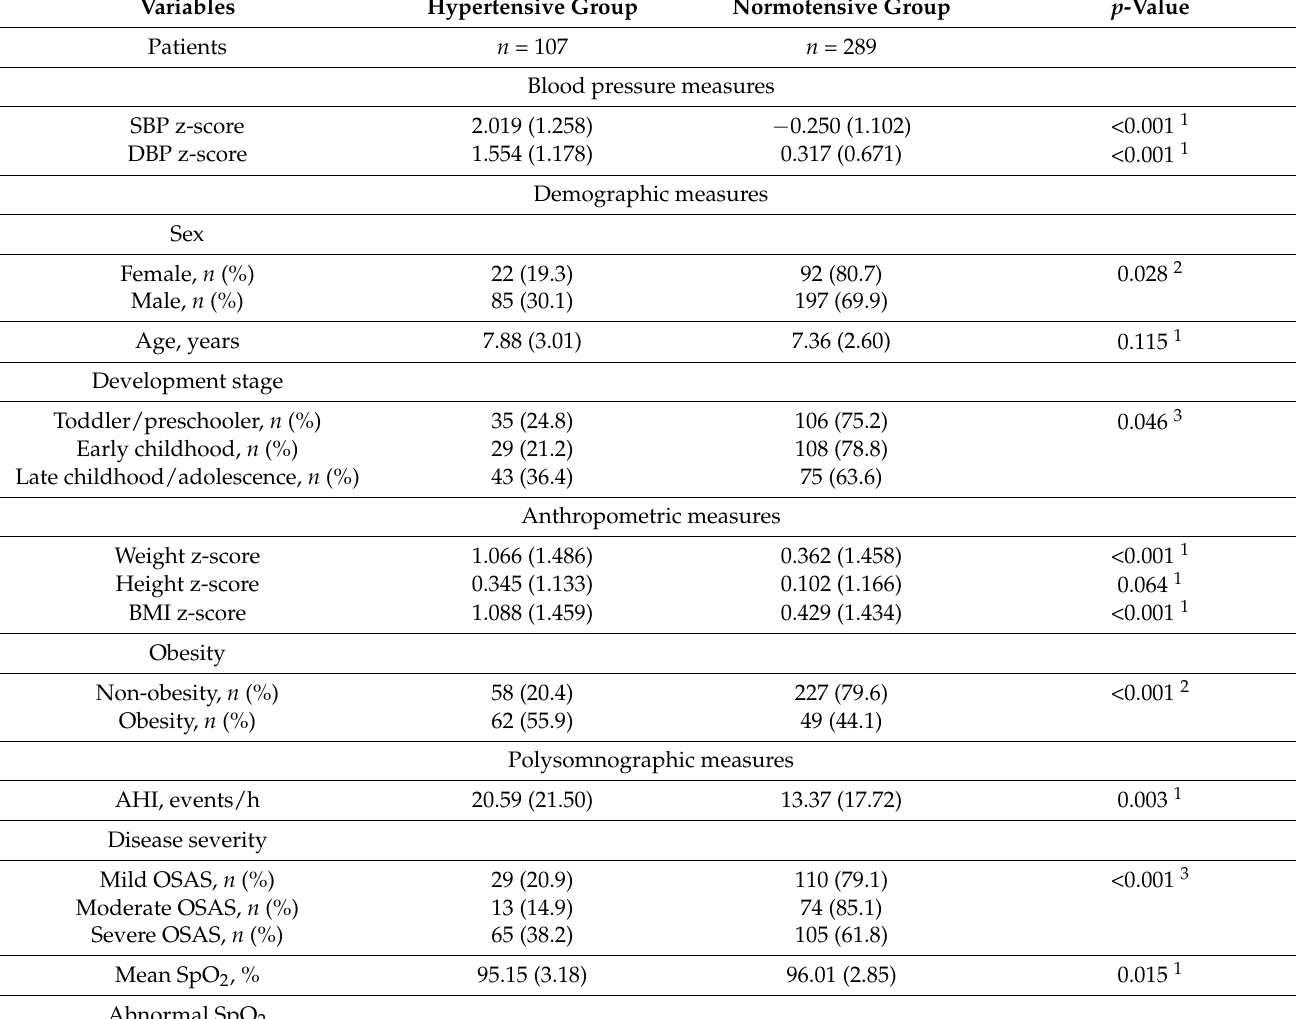
Table 1. Comparisons of clinical variables between the hypertensive and normotensive